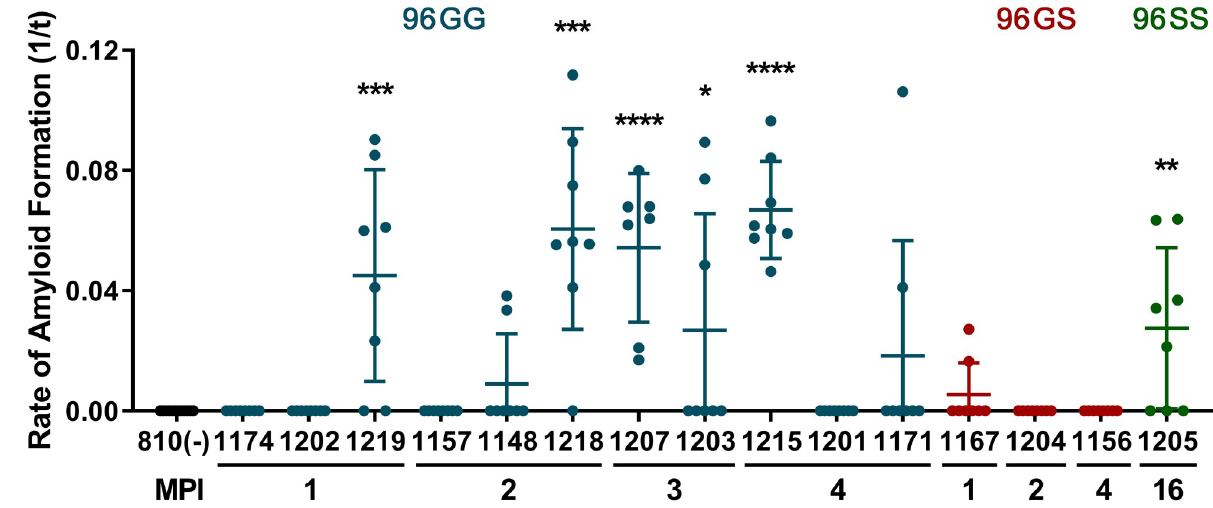
Fig 3. Detection of PrP CWD in third eyelids of pre-symptomatic deer by RT-QuIC. CWD prions were detected by RT-QuIC in the third eyelid of a 96GG deer as early as 1 month post-inoculation. RT-QuIC analysis of 96GG negative-control (black), 96GG (blue), 96GS (red), and 96SS (green) third eyelids collected in chronological order of months post-inoculation (MPI). 6 samples displayed statistically significant RT-QuIC amyloid seeding: 1219, 1218, 1207, 1203, 1215, and 1205 ( ���� p < 0.0001, ��� p < 0.001, �� p < 0.01, � p < 0.05, two-tailed Mann-Whitney test) when compared with respective negative control tissues. Each third eyelid sample is represented by the mean and standard deviation from at least eight replicate wells.